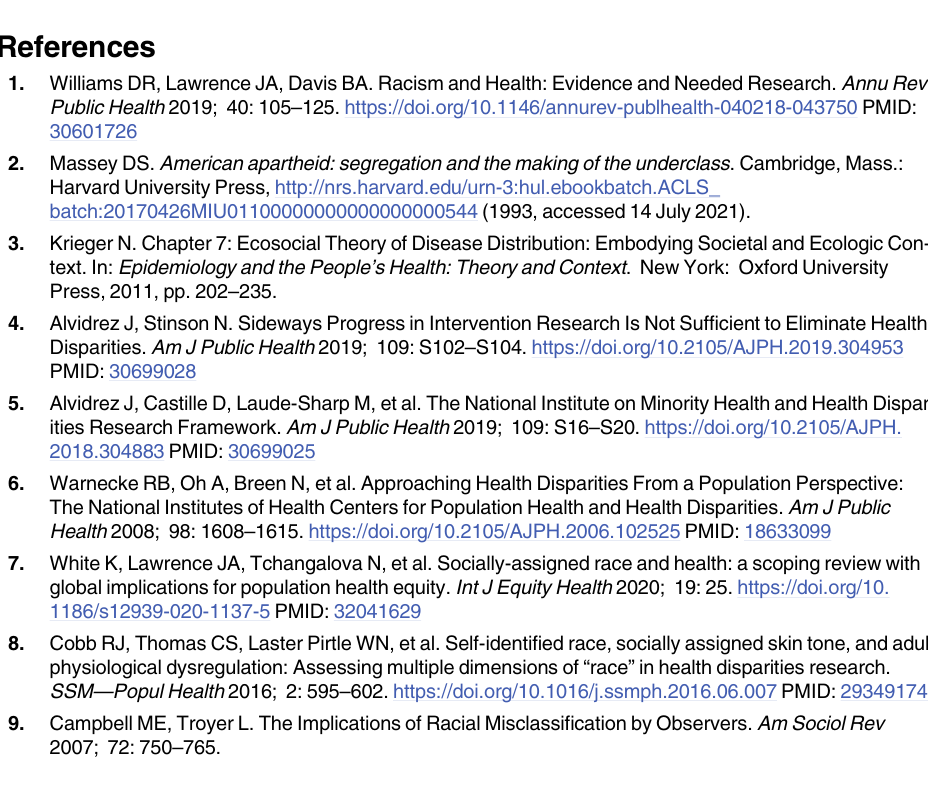
S5 Table. Hazard ratios for association between African Ancestry and all-cause mortality among self-identified African American participants by levels of nSES in the prostate, lung, colorectal, and ovarian cancer trial, United States, 1993–2019. a Per 10 percentage point increase in African ancestry. Models adjusted for age, sex, smoking, marital status, edu- cation, Body Mass Index, diabetes, hypertension, and census tract % Non-Hispanic Black resi- dents.